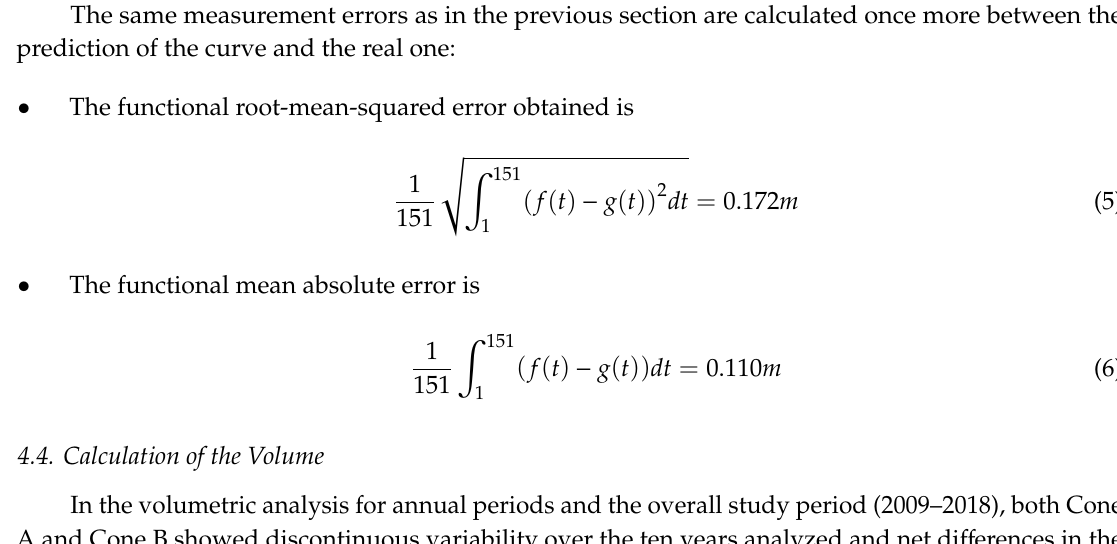
Figure 12. Representation of the di ff erence between two results. The data are obtained as a prediction of 2018 and the real measured values of 2018 of profile 3, Cone